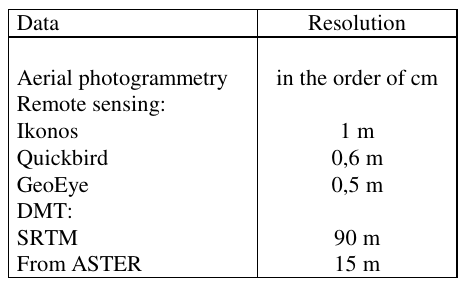
Table 1. Accuracy of the available